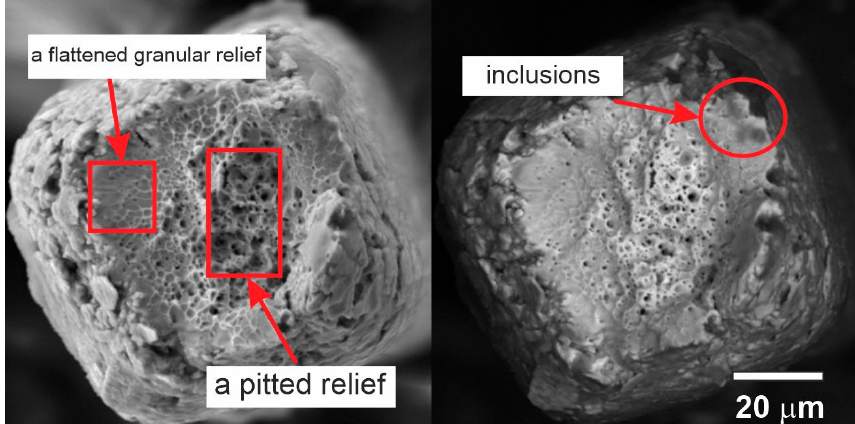
Figure 10. The fracture surfaces of a 60 µm thick NiTi wire.